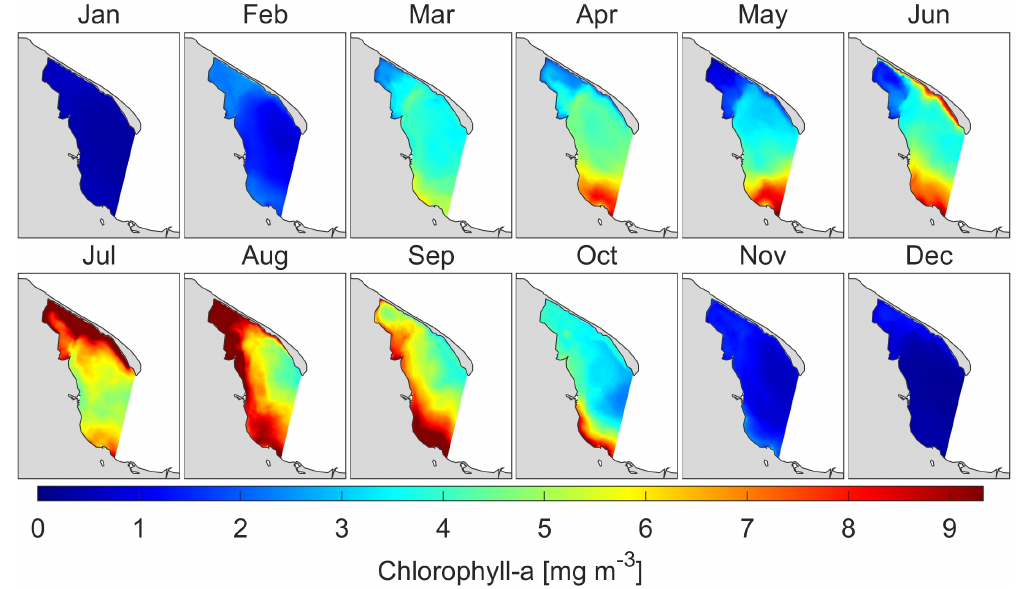
Figure 8. Monthly means of chlorophyll-a concentration at sea